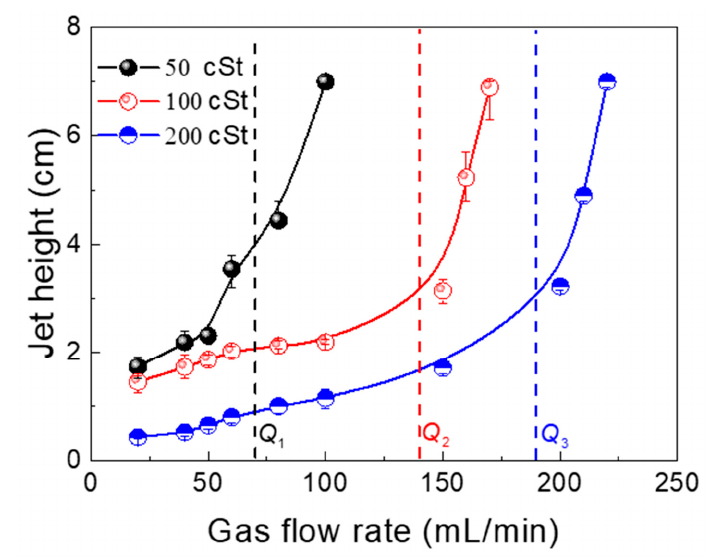
Figure 10. Jet height with different gas flow rates.